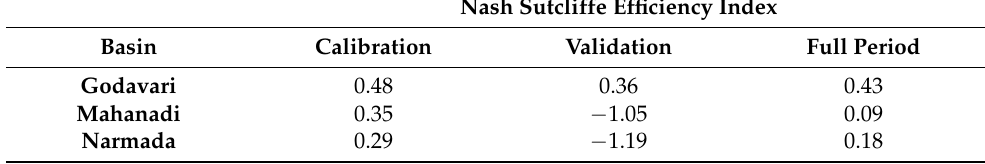
Table 3. Result of the particle swarm optimization. Each of the three basins was optimized indi- vidually using the Nash–Sutcliffe efficiency index as the objective function computed from daily simulations of basin